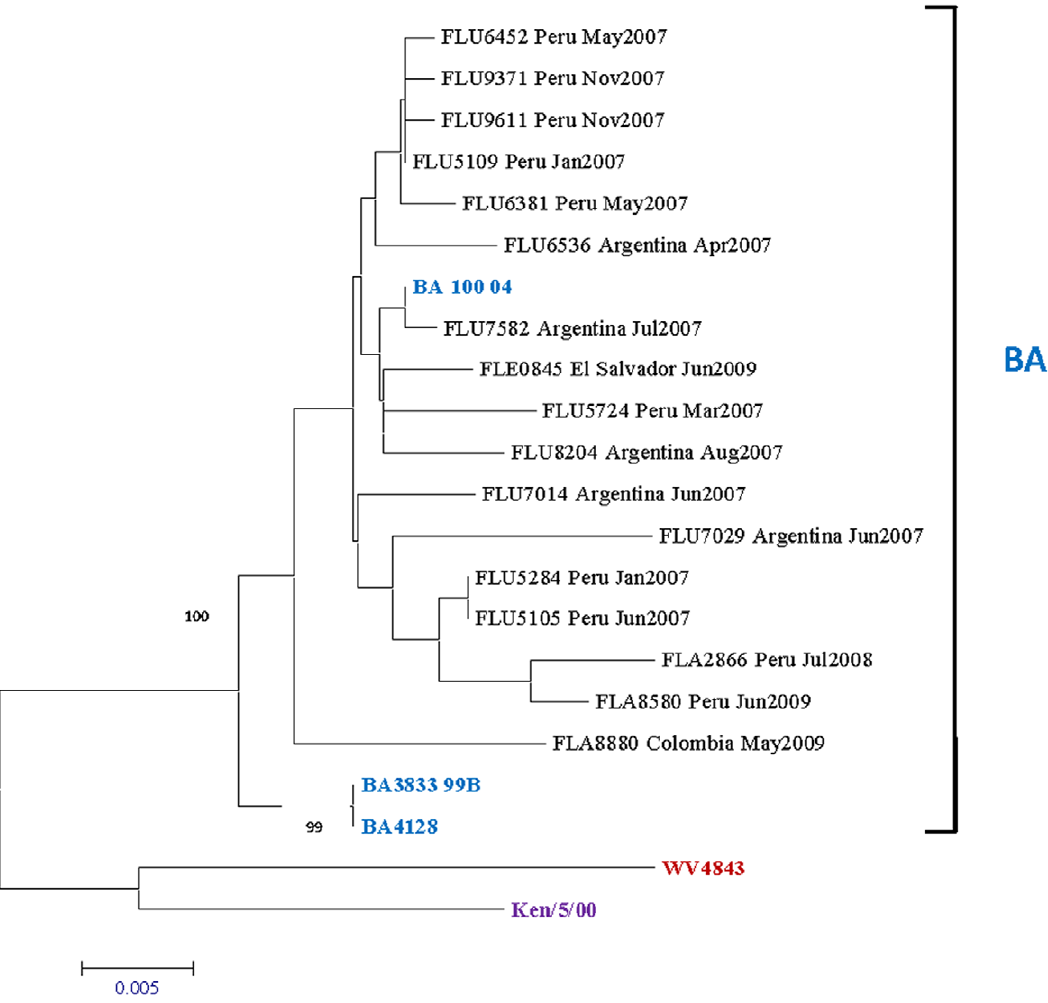
Figure 3. HRSV subgroup B Phylogenetic Tree. 630 nucleotides of the variable region of G protein gene were amplified, sequenced, and compared to published sequences from GenBank. Labeling and analysis were performed as in Figure 2.